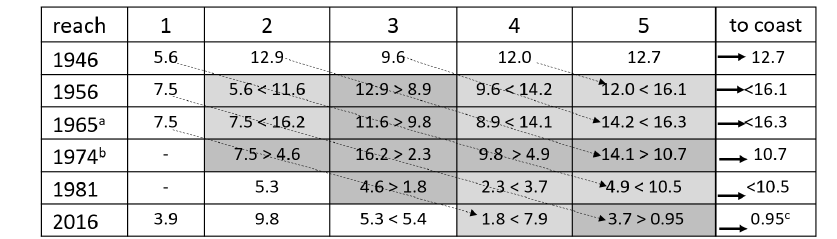
Dark and light grey boxes have the same meaning as above. Dotted lines with arrows mean transference to the next reach and decade and arrows mean transference to the coast. The symbols a , b and c in Table 5 apply here